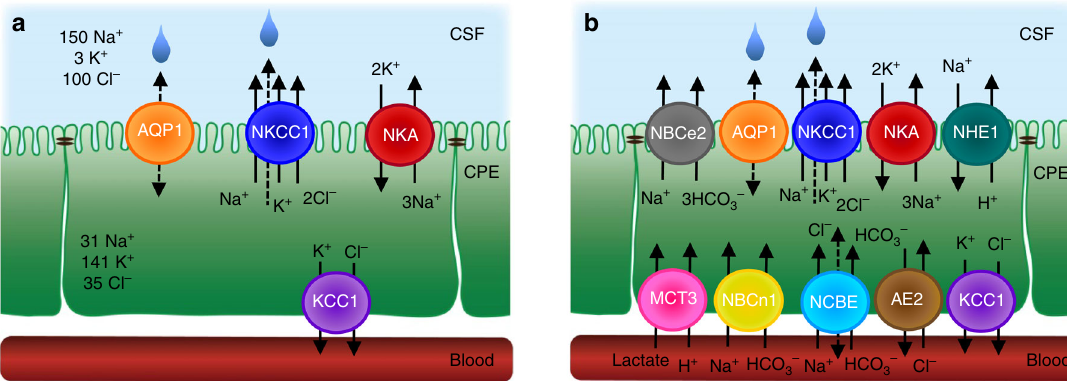
Fig. 7 Schematic drawing of transporters in a choroid plexus epithelial cell. a The drawing depicts the selective expression of NKCC1 at the luminal membrane and indicates its unique outward transport direction, due to the high intracellular concentration of Na + and Cl − in this tissue (ion concentrations given in mM). The NKCC1-mediated cotransport of water is indicated with a dashed arrow. The Na + /K + -ATPase and AQP1 14 are indicated on the luminal membrane of the choroid plexus epithelium (CPE), while KCC1 is localized to the basolateral membrane facing the vascular compartment (this study). b The drawing includes the many other coupled transporters localized to the choroidal epithelial membranes 1 . Note that NCBE may also be referred to